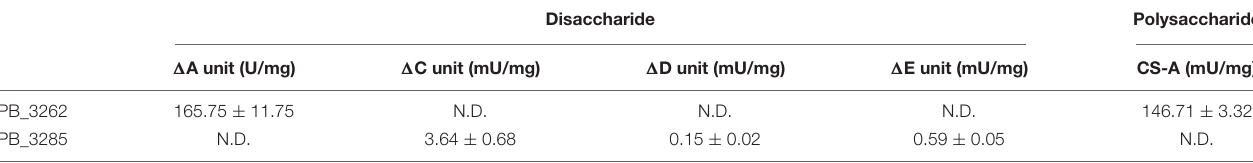
TABLE 2 | Specific activities of PB_3262 and